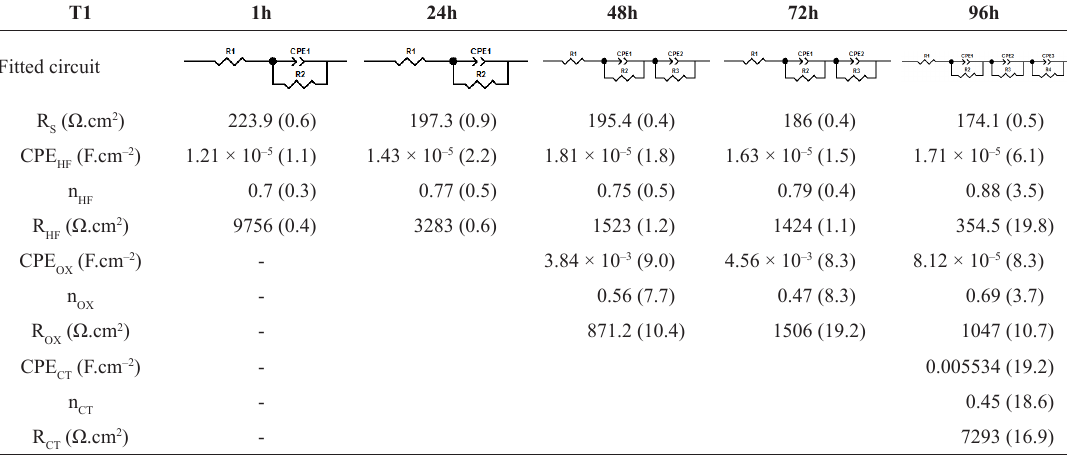
Table 6. Electrical elements fitted values for the T1 sample up to 96 hours of immersion in a 0.05 mol.L –1 NaCl solution. The error percentage associated with each parameter value is given in parenthesis.